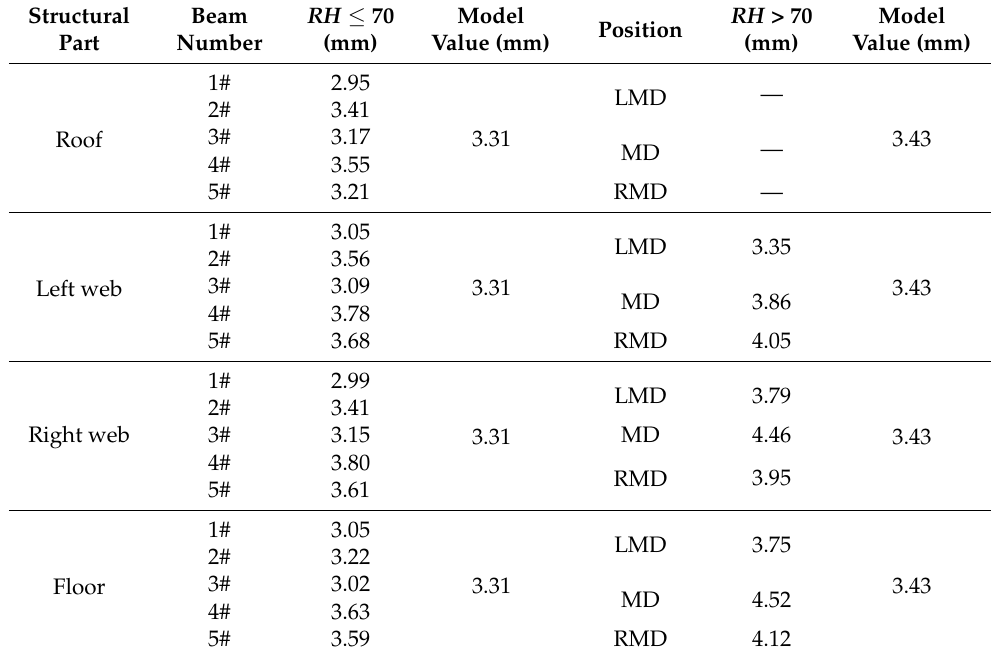
Table 8. Measured value and model calculated